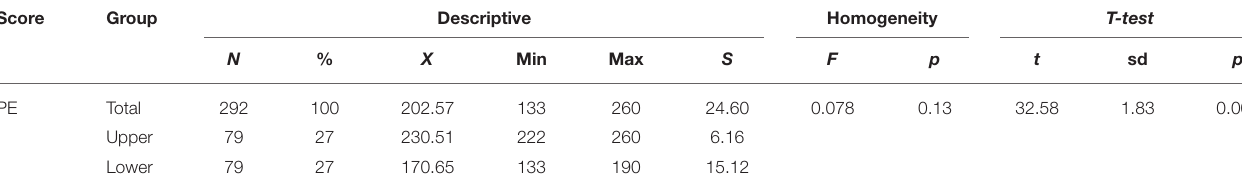
TABLE 4 | Independent group T -test for the comparison of upper 27% and lower 27%